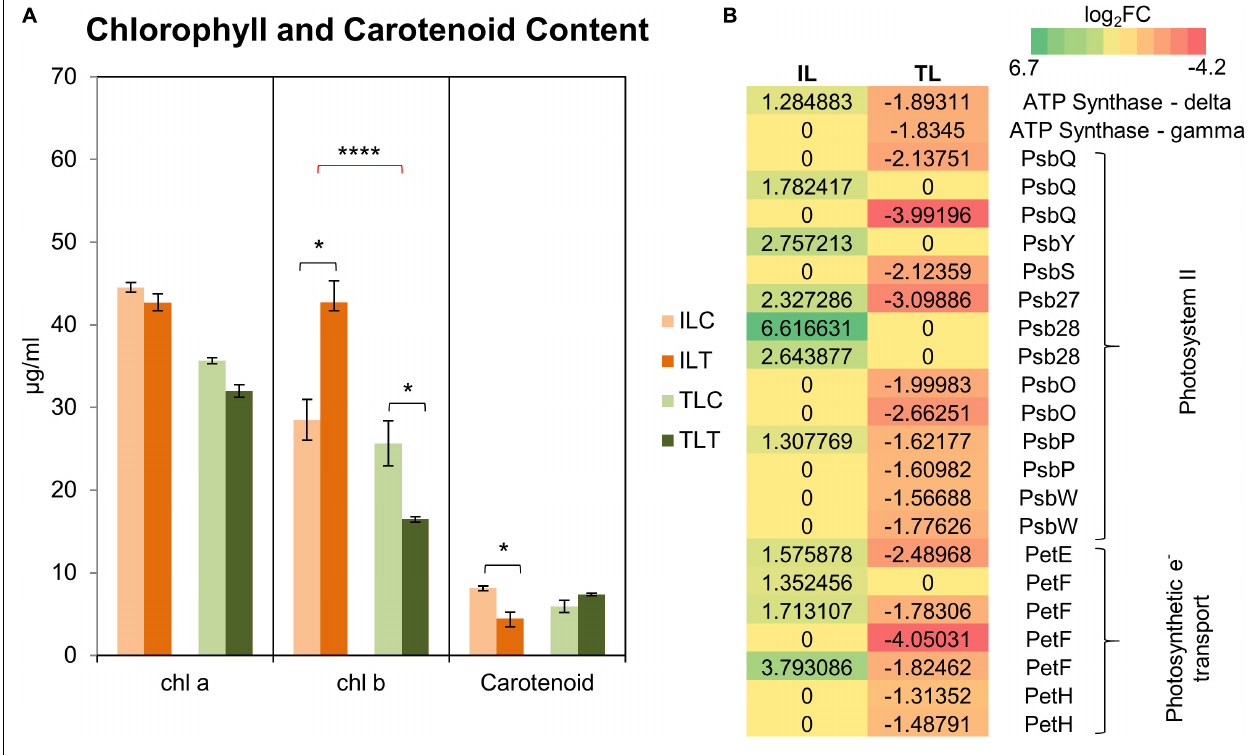
of amino acids and ribosome biogenesis ( Figures 2B , 3B